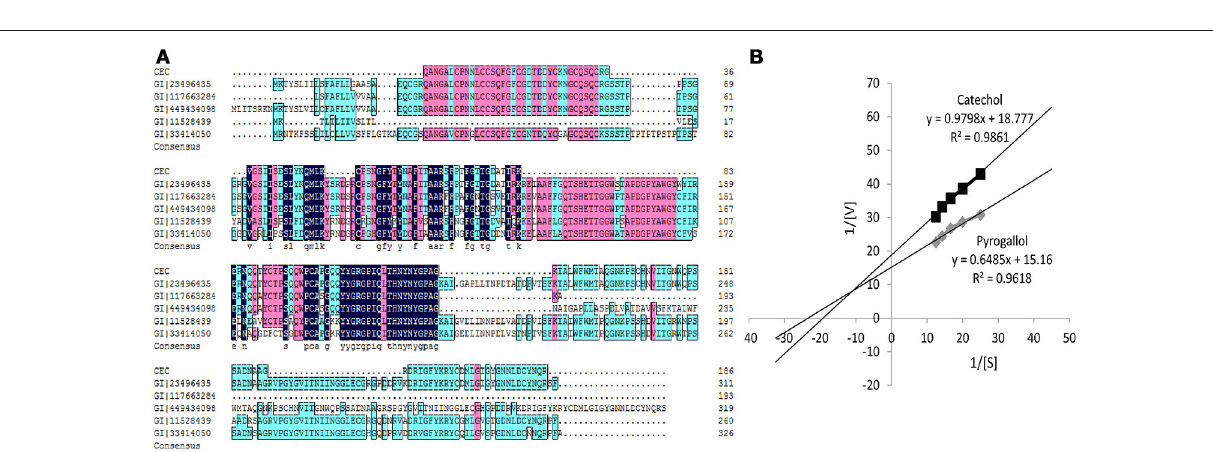
FIGURE 2 | (A) Peptides sequenced alignment of BRP purified from sweet melons. (B) Km values of catechol and pyrogallol substrates for BRP. The vertically intercept was 1/ V max while the horizontally intercept was 1/ K m . All data were the means of three independent experiments ( P < 0.05, n =